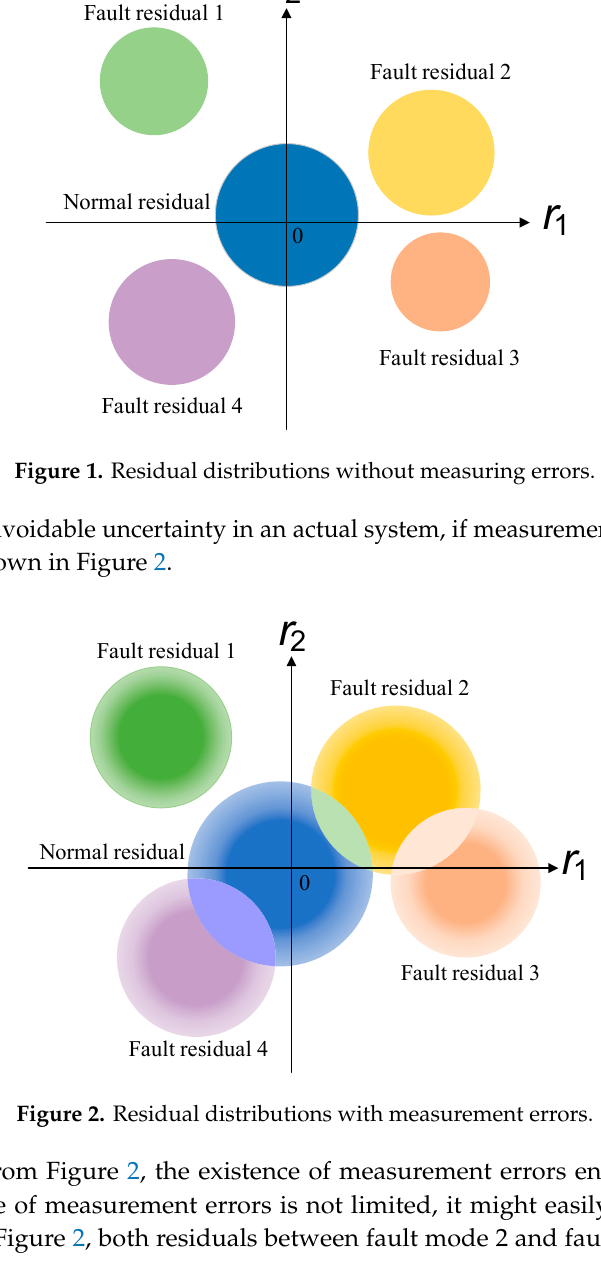
Figure 2. Residual distributions with measurement errors.